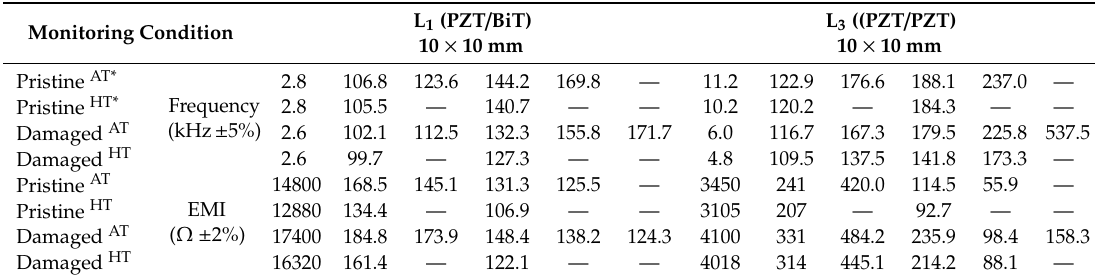
Table 1. Anti-resonance frequency of the blades L 1 and L 3 at 20 and 200 °C, using the IVIUM analyzer.